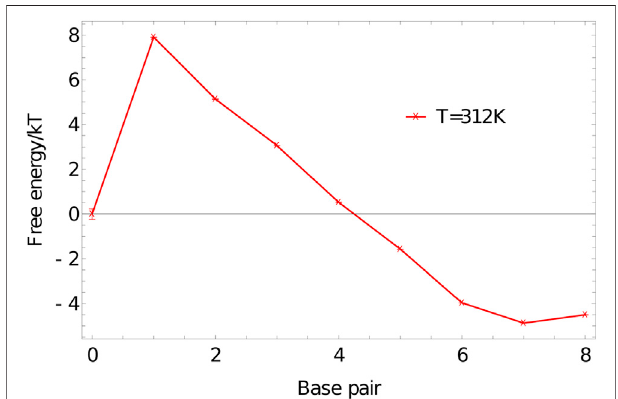
FIGURE7| Free-energypro fi leofan8-base-pairduplex(3 ′ -ACTGACGT-5 ′ and 3 ′ -ACGTCAGT-5 ′ ) at 312K in a simulation volume of side length 15 units.